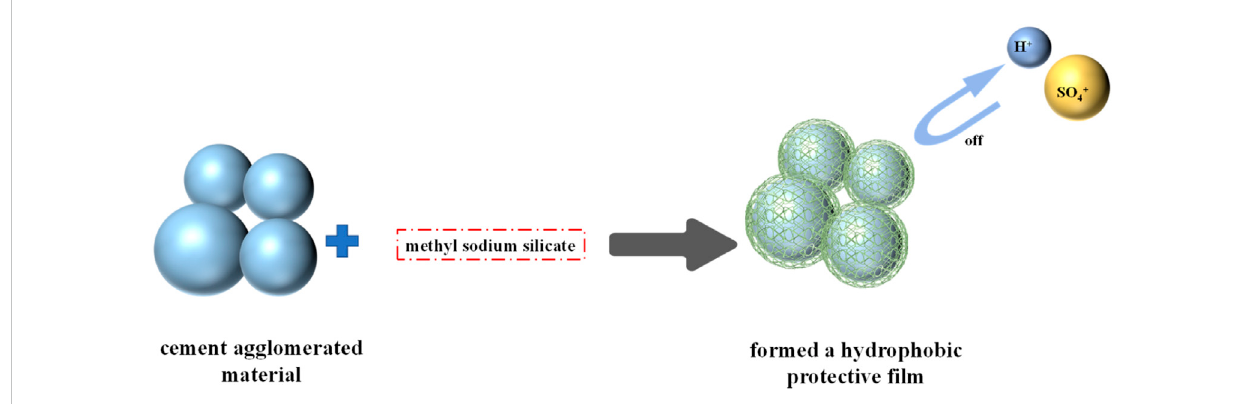
FIGURE 13 Waterproof mechanism of sodium methyl